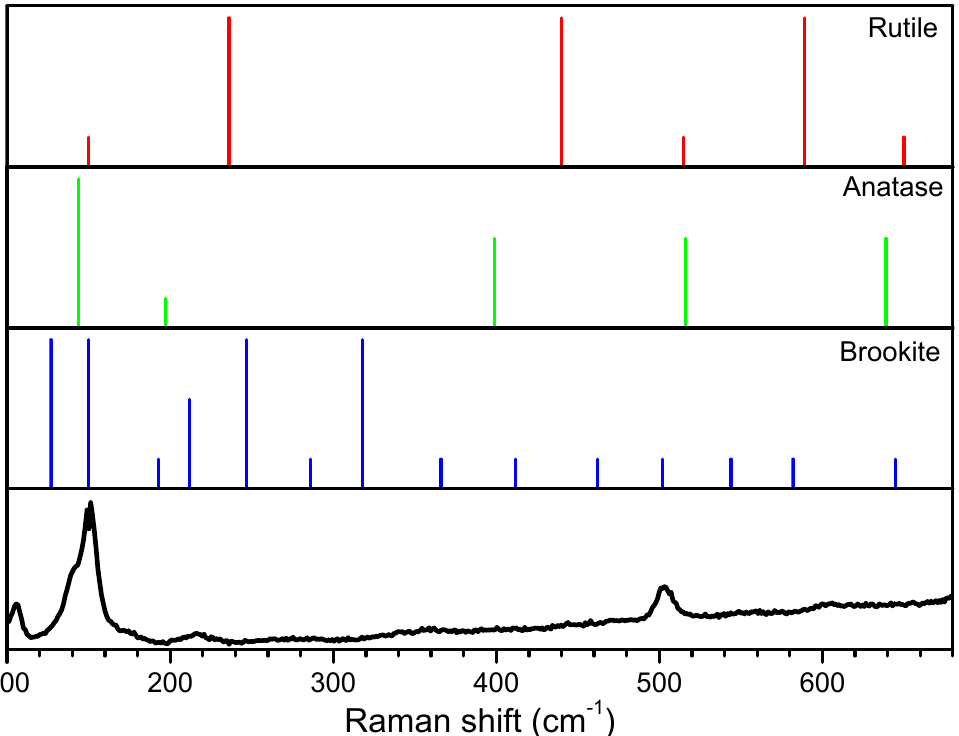
Figure 13. Raman spectrum of titanium dioxide nanoparticles formed using pulsed discharge plasma [43].